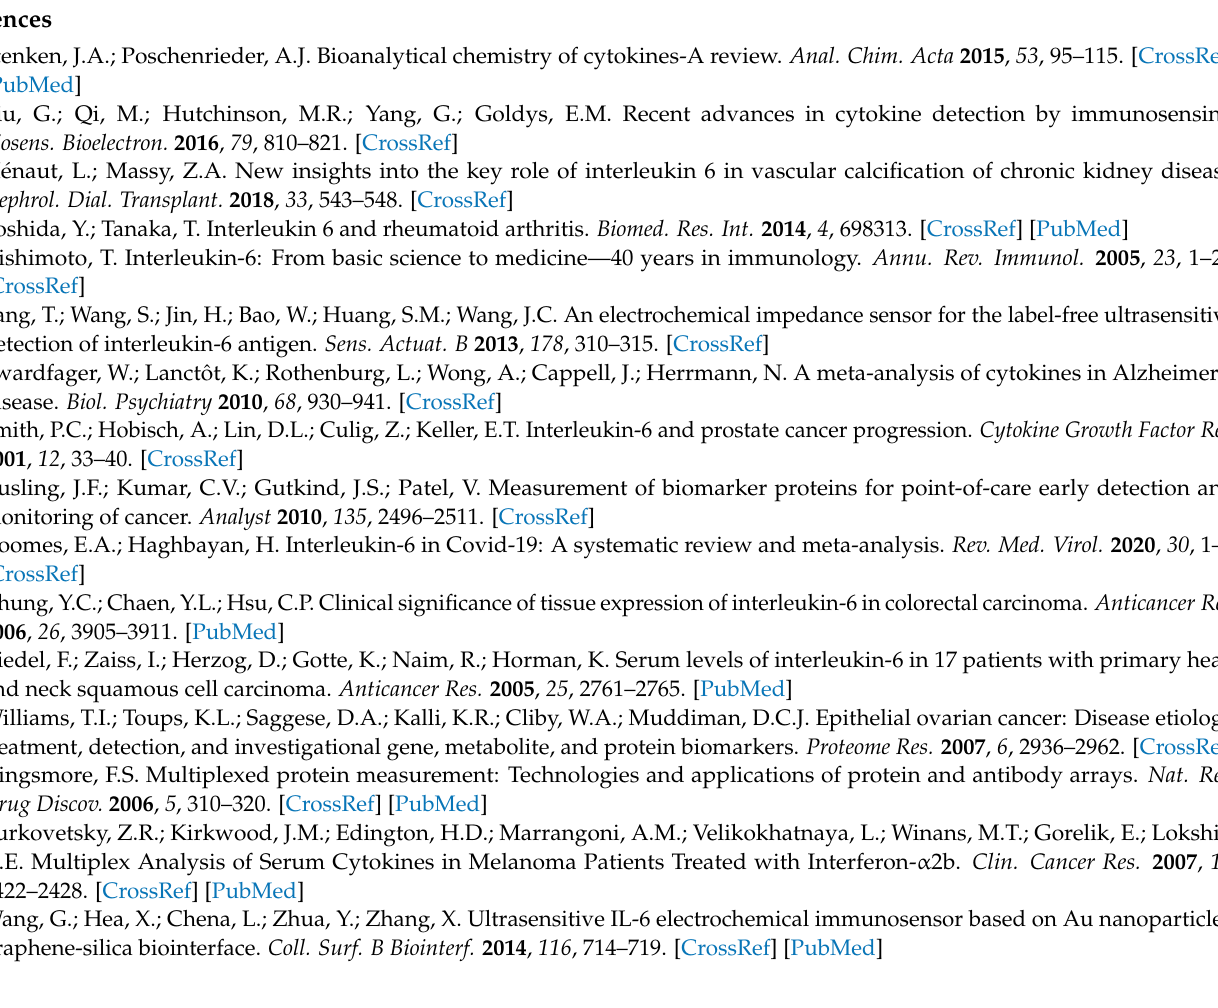
1-PBA concentration, Figure S3: Optimization of NHS:EDC coupling conditions, Figure S4: Optimiza- tion of anti-IL6 concentration conditions. Limit of detection calculation, Figure S5: Benchmarking against ELISA test, Figure S6: Biosensor shelf